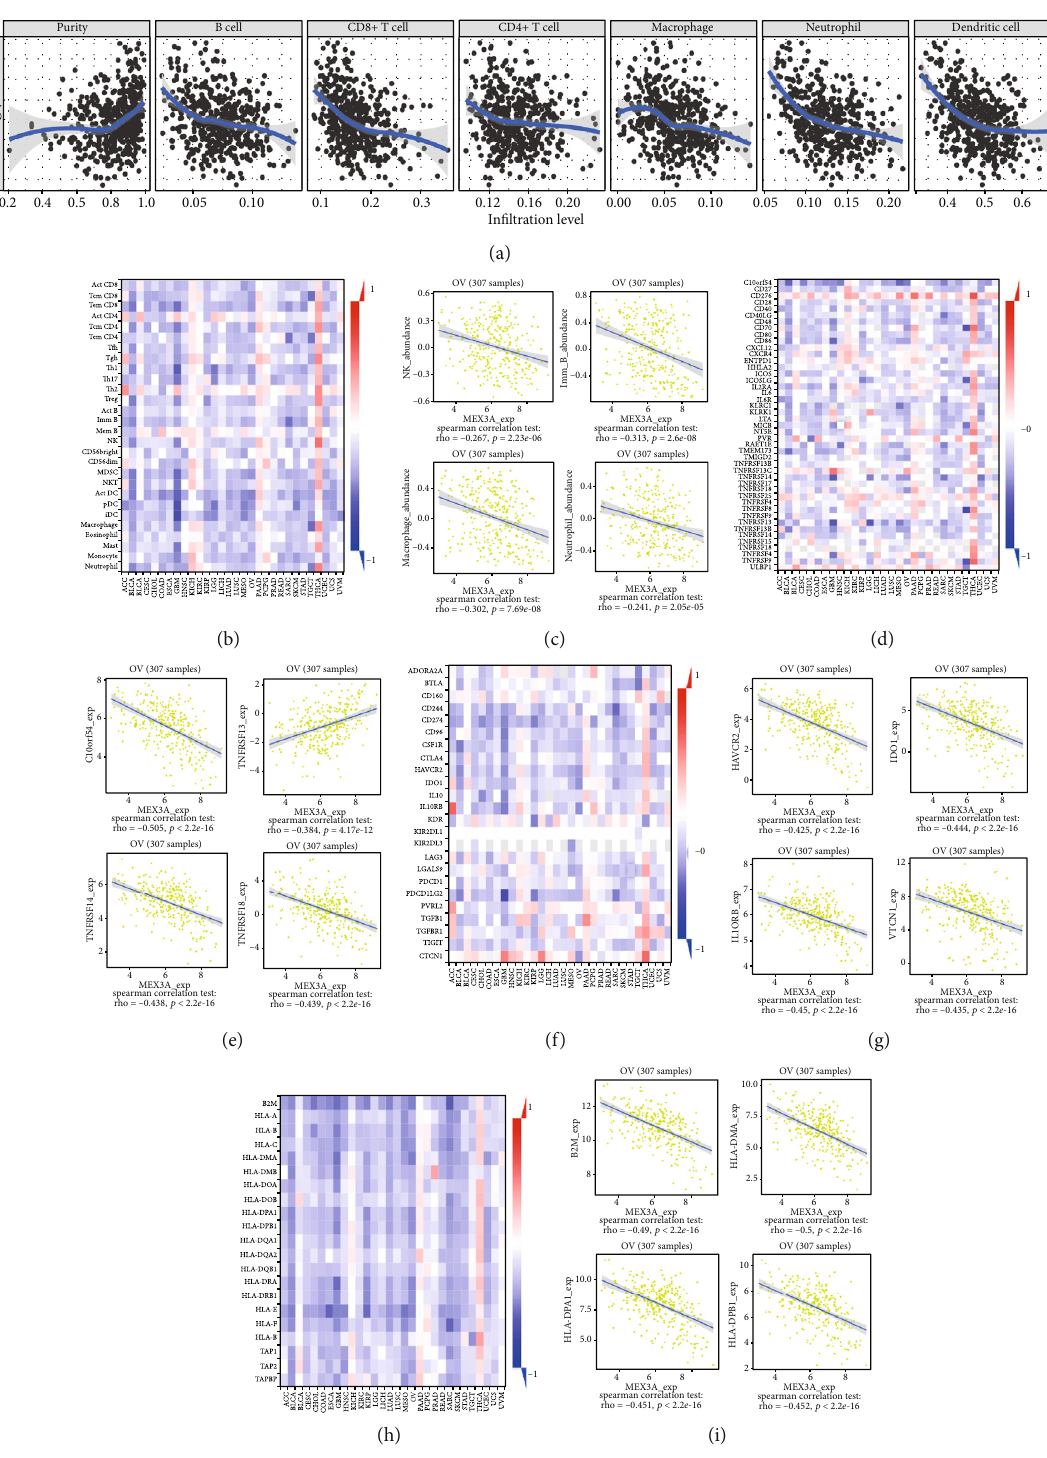
Figure 2: Correlation of MEX3A expression with immune in fi ltration level in OC. (a) Correlation of MEX3A expression with immune in fi ltration level in OC (TIMER). Spearman ’ s correlation of MEX3A with lymphocytes and immunomodulators (TISIDB). (b) Heat maps of correlations between MEX3A expression and TILs by TISIDB. (c) Scatterplots of correlations between MEX3A expression and top 4 TILs. (d) Heat maps of correlations between MEX3A expression and immunostimulators. (e) Scatterplots of correlations between MEX3A expression and top 4 immunostimulators. (f) Heat maps of correlations between MEX3A expression and immunoinhibitors. (g) Scatterplots of correlations between MEX3A expression and top 4 immunoinhibitors. (h) Heat maps of correlations between MEX3A expression and MHC molecules. (i) Scatterplots of correlations between MEX3A expression and top 4 MHC molecules. Red and blue represent positive and negative correlations. The color intensity is directly proportional to the strength of the correlations. ∗ P < 0 : 05 , ∗∗ P < 0 : 01 , and ∗∗∗ P < 0 : 001